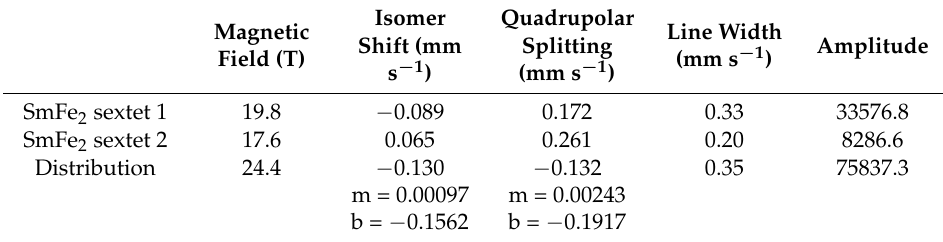
Table 2. Hyperfine parameters of the SmFe 2 sample.